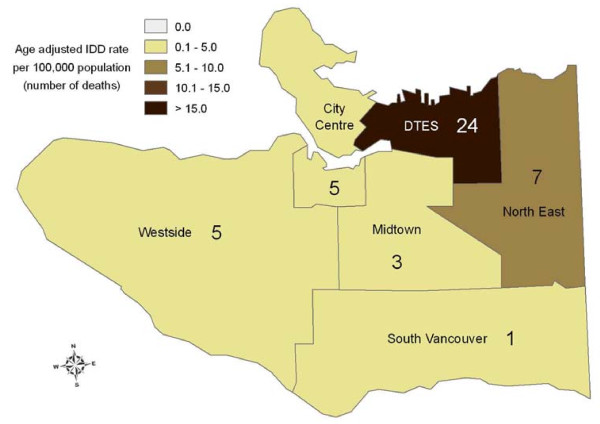
Illicit Drug Deaths in the City of Vancouver by local health area, 2006. Illicit Drug Deaths (IDD)are mapped by place of residence. Three additional IDD could not be mapped due to missing geolocator information.